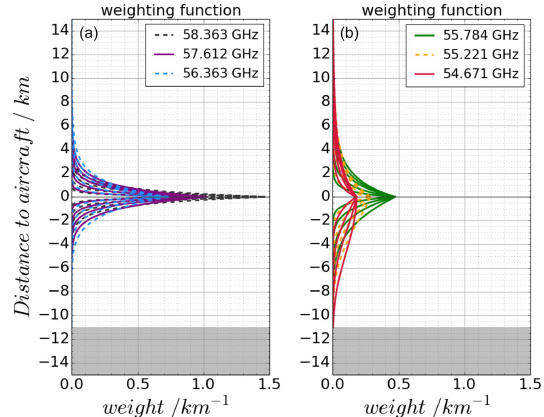
Figure A1. WFs (averaged over all contributing frequencies within filter transmission range) of the MTP frequency channels (each indi- vidual line corresponding to a different viewing angle), calculated at an aircraft altitude of 11km. Shown are the three standard fre- quency channels (a) and three possible frequency channels (b) to be considered in a new measurement strategy for the HALO MTP. Grey areas at the bottom: altitude range that would be below the sur- face. Note that the black curves for the 58.363GHz measurements are almost entirely covered by the other